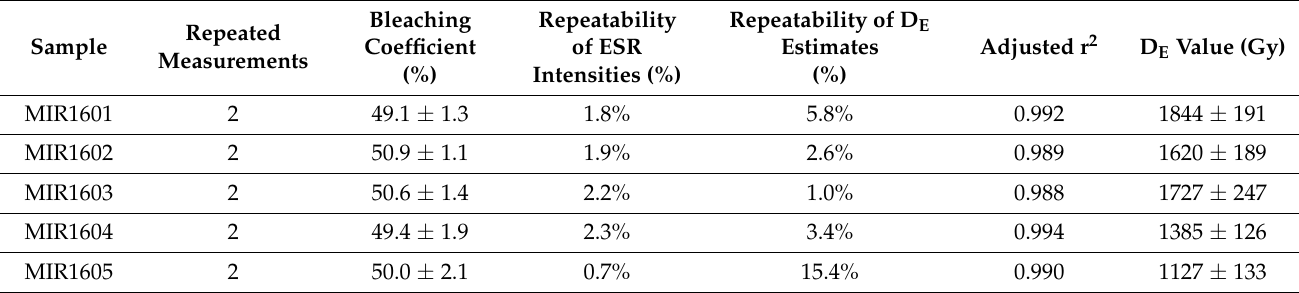
Table 2. ESR data derived from measurement of Al center. Bleaching coefficient is expressed as relative difference between ESR intensities of natural and bleached aliquots. Repeatability of ESR intensities is assessed through variability (1 relative standard deviation) of mean ESR intensities obtained after each day of measurement. Similarly, repeatability of D E values corresponds to variability (1 relative standard deviation) of D E values calculated for each day of measurement.